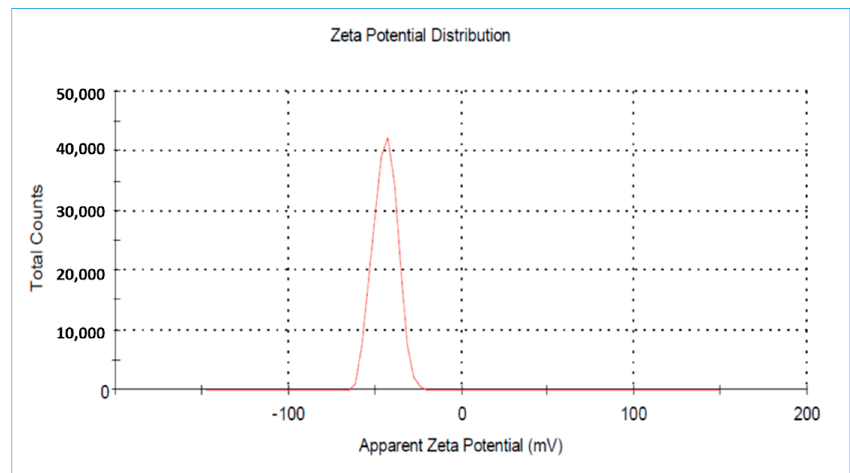
Figure 5. Zeta potential distribution of Hap/CS nanocomposite.